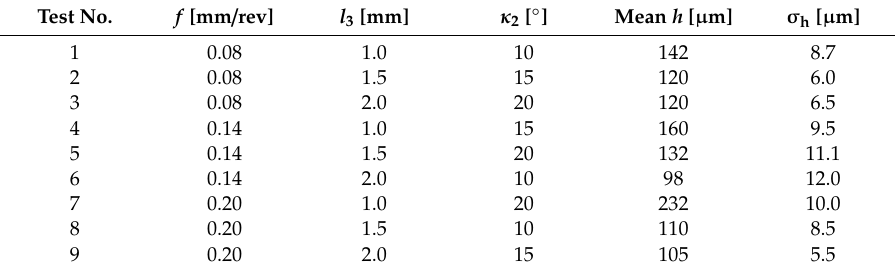
Table 5. Burr height depending on the shape of the tool used and on the